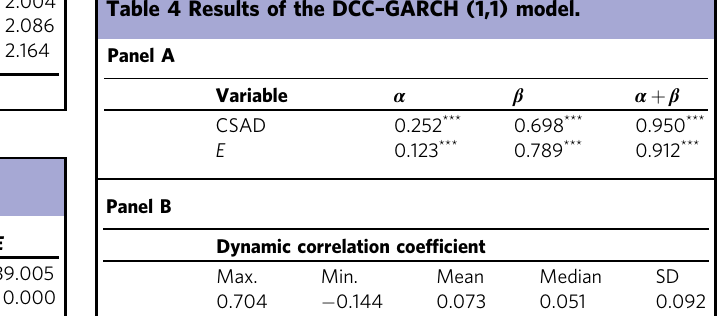
Table 4 Results of the DCC – GARCH (1,1)